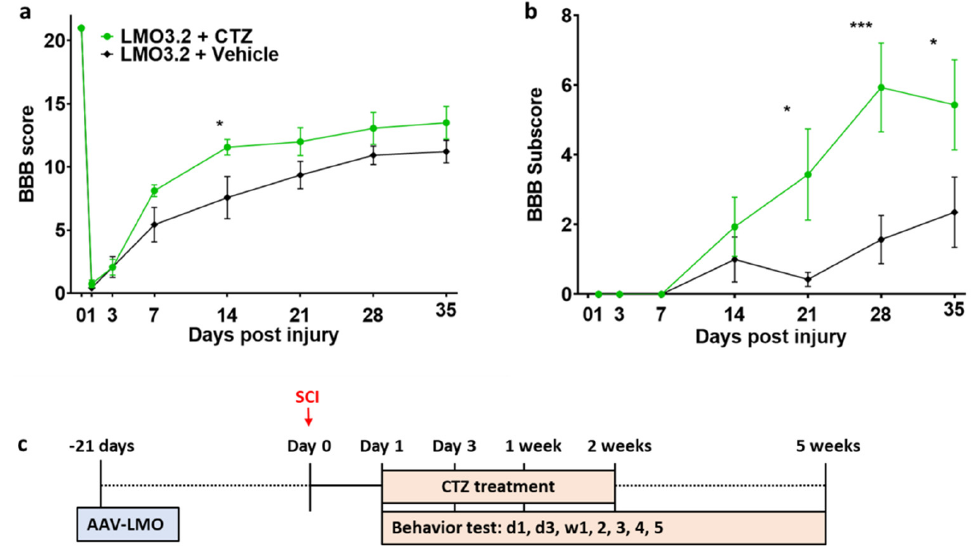
Figure 4. Rats expressing the CheRiff-containing LMO3.2 and treated with CTZ showed improved locomotor function after SCI. BBB locomotor rating score ( a ) and subscore ( b ) were performed to assess functional recovery of rats’ hind limbs at Day 1, Day 3, Week 1, Week 2, Week 3, Week 4, and Week 5 following spinal cord injury. LMO3.2 + vehicle ( n = 7) and LMO3.2 + CTZ ( n = 8). LMO3.2 + CTZ vs. LMO3.2 + vehicle: * p < 0.05, *** p < 0.001. Error bars ± standard error of mean (SEM). ( c ) Timeline for experimental procedures. The virus was injected three weeks before spinal cord injury with CTZ injections every other day for two weeks following the injury. Behavior testing was con- ducted starting the day after the injury and for five weeks post-injury.